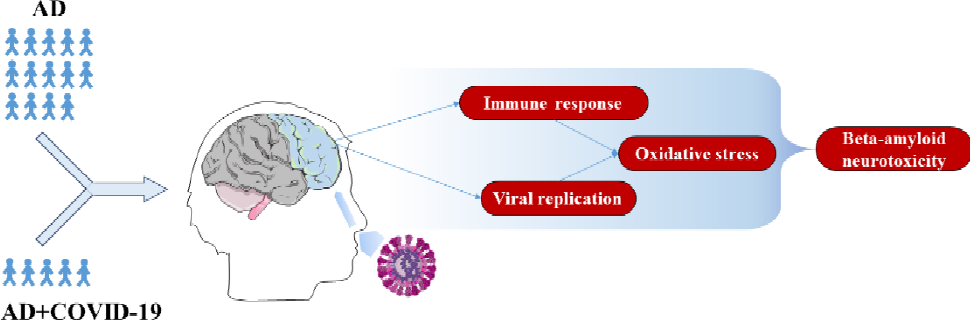
Figure 5. Summary of the effects of COVID-19 in AD patients. The olfactory epithelium is the possible access route of SARS-CoV-2 in the human brain; thus, the frontal cortex area should be the first brain region to be damaged from the invasion. The comparative analysis of 14 individuals who died with AD against 5 patients who died from COVID-19 (AD+COVID-19) revealed a reduction in apoptosis that leads to a prolonged viral replication. Along with immune response activation, SARS-CoV-2 increases the oxidative stress that culminates in enhanced beta-amyloid neurotoxicity.